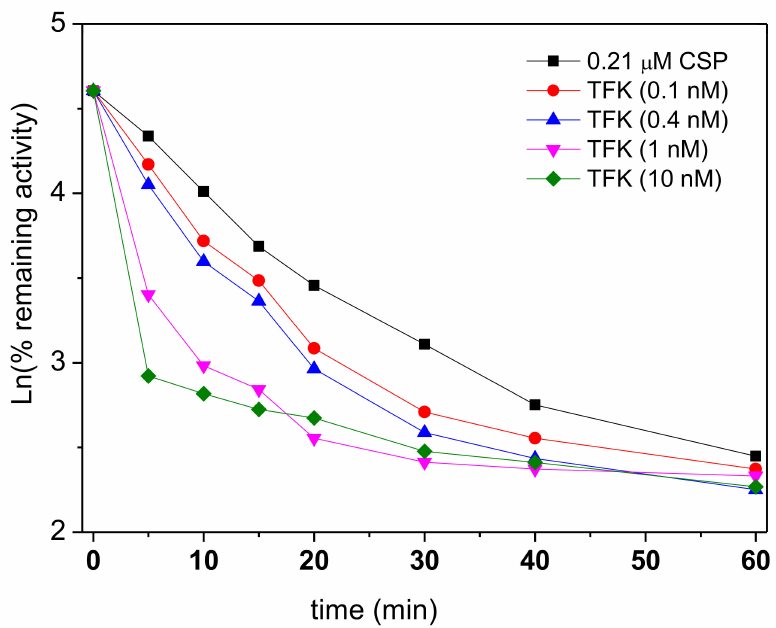
Figure 10. Modulation of progressive biphasic inhibition of hAChE by CBDP CSP (0.21 µ M) after pre-incubation of the enzyme for 120 min in the presence of TFK (0.1–10 nM).